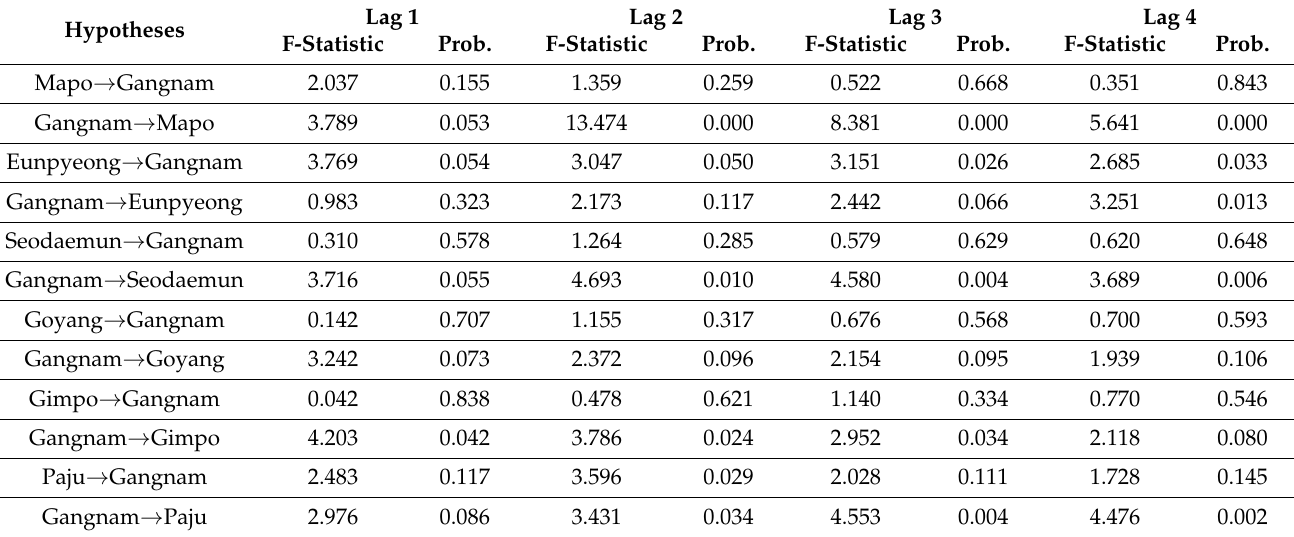
Table 11. Granger causality analysis of sales prices in Gangnam, Northwest region, and Gyeongeui region.